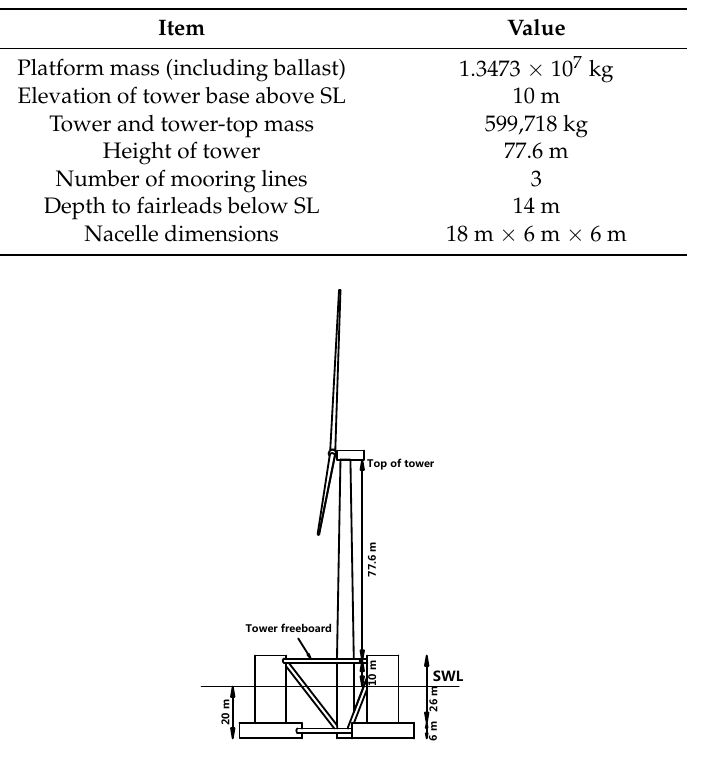
Figure 1. Diagram of DeepCwind semi-submersible.